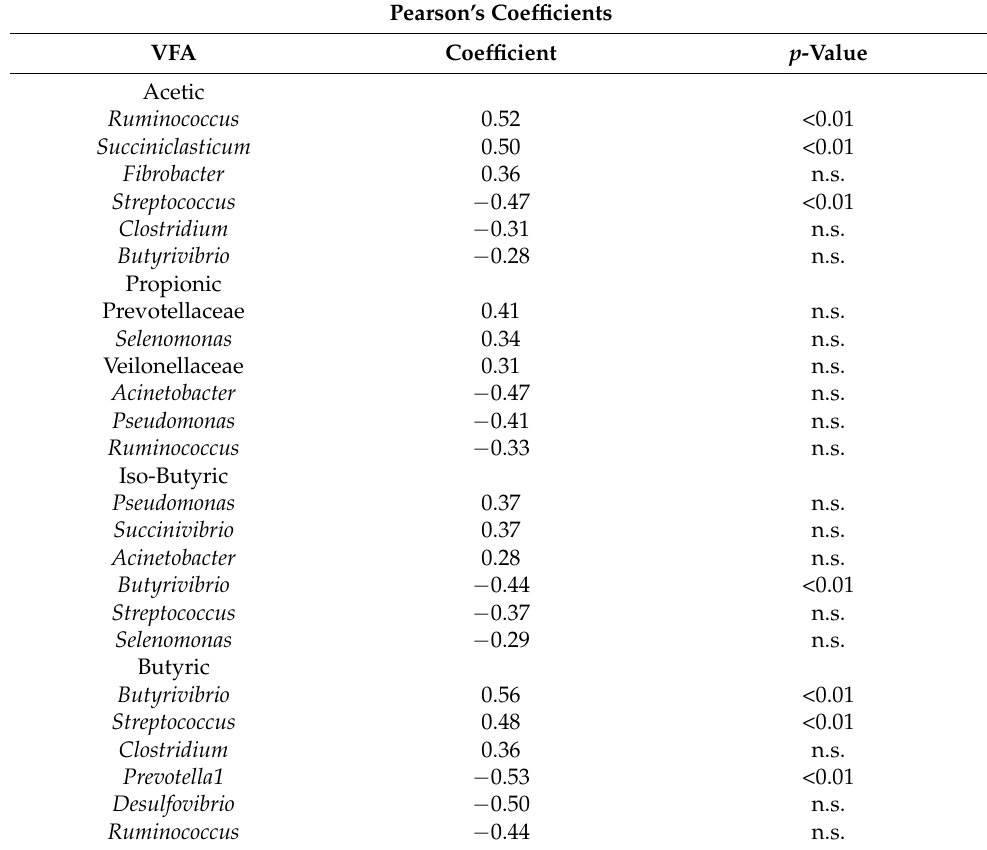
Table 6. Pearson’s coefficients of major correlations observed among VFAs and bacteria